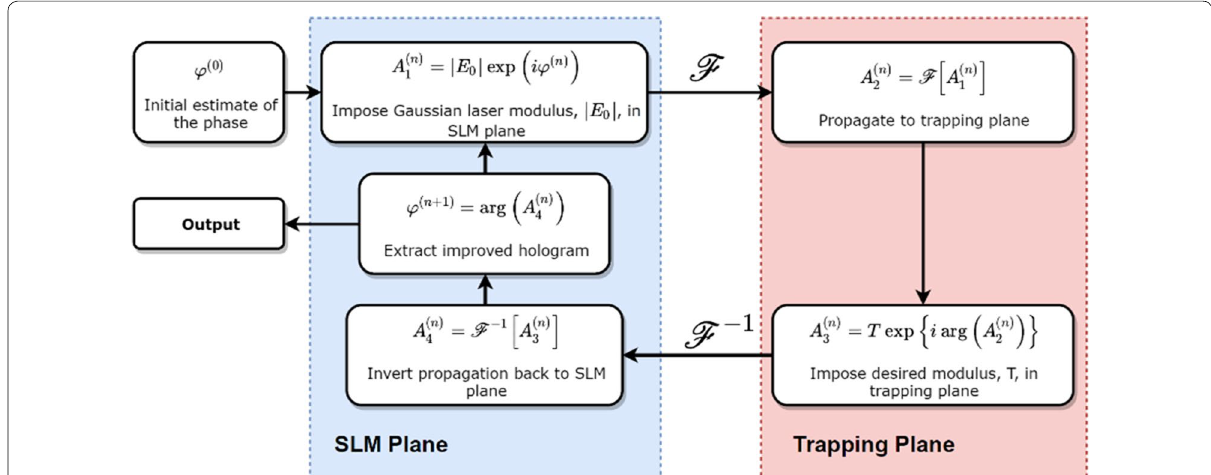
Fig. 6 Gerchberg-Saxton algorithm. The hologram, φ ( r ), is generated in the SLM plane, thus shaping the input Gaussian laser beam into a desired state, which is projected onto the trapping plane. F denotes the Fourier transform. F − 1 is the inverse Fourier transform. After several iterations the resulting hologram converges to a hologram that generates multiple optical traps with equally distributed intensity (Adapted from